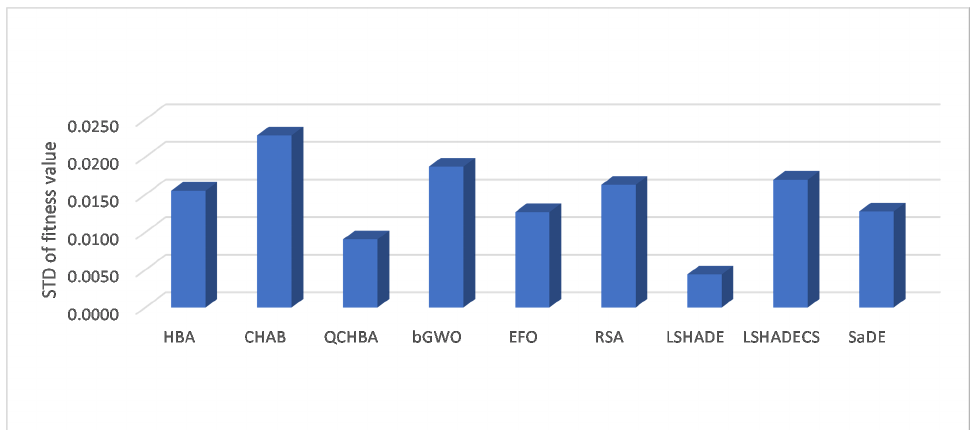
Figure 2. Competitive results of QCHBA and other methods in terms of average fitness values.